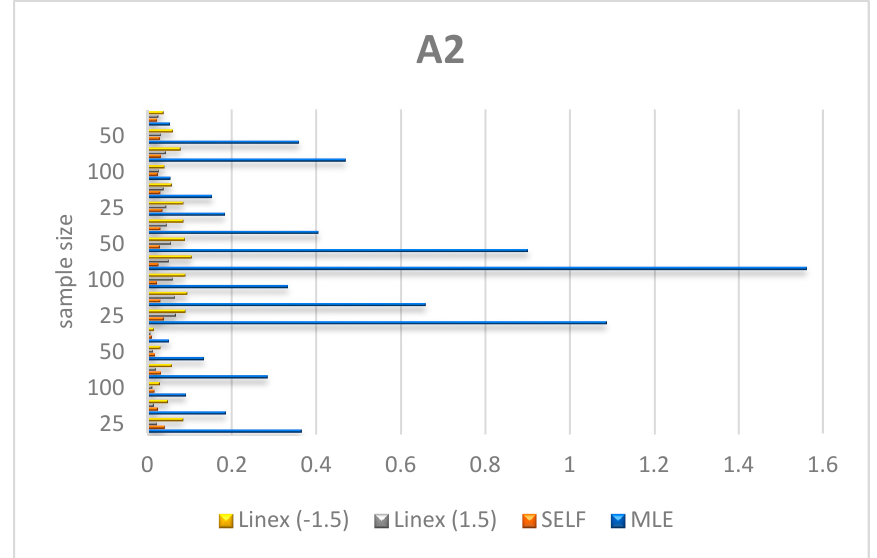
Figure 6. Plot A2 of 𝜃 by results in Table 1.